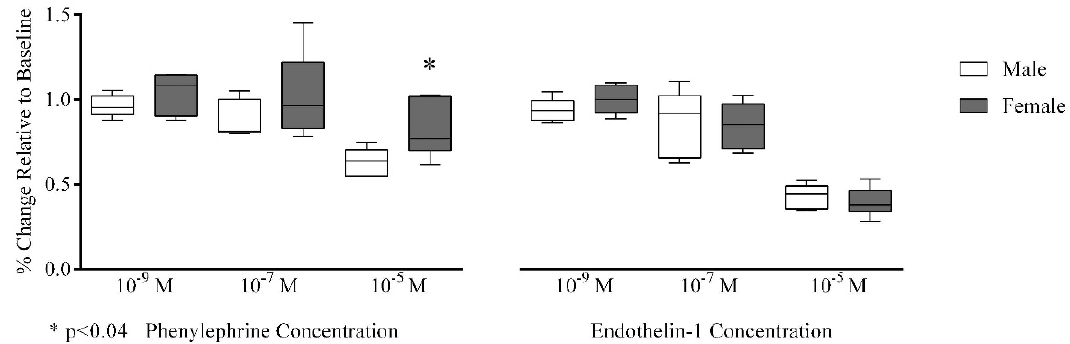
Figure 3 - Arteriolar vasoconstriction induced by phenylephrine and endothelin-1 according to